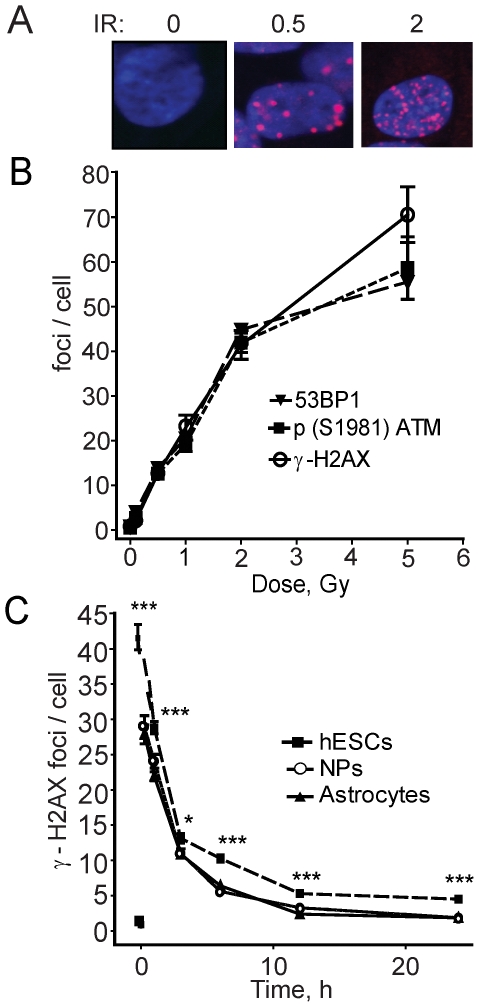
Characterization of repair foci formation and resolution in hESCs, neural progenitors and astrocytes.
A. Depicted is immunostaining of hESCs after treatment with 0, 0.5, and 2 Gy and exposed to p-(S1981) ATM antibody 15 min after radiation. B. Immunostaining of 53BP1, p-(S1981) ATM, and γ-H2AX foci 15 min after irradiation in hESCs after doses from 0.1 to 5 Gy. n = 30 cells per time point. C. Graphical depiction of the number of γ-H2AX foci in hESCs, NPs and astrocytes exposed to 2 Gy over 24 h. Data are expressed as mean IRIF per cell. n = 100 cells per time point. There was <1 focus on average in the untreated hESC, NP and astrocyte populations (shown as symbols at time 0). Error bars indicate the standard error of the mean (SEM). Asterisks indicate statistical significance between the number of foci observed in hESCs, NPs, and astrocytes at the same time point.